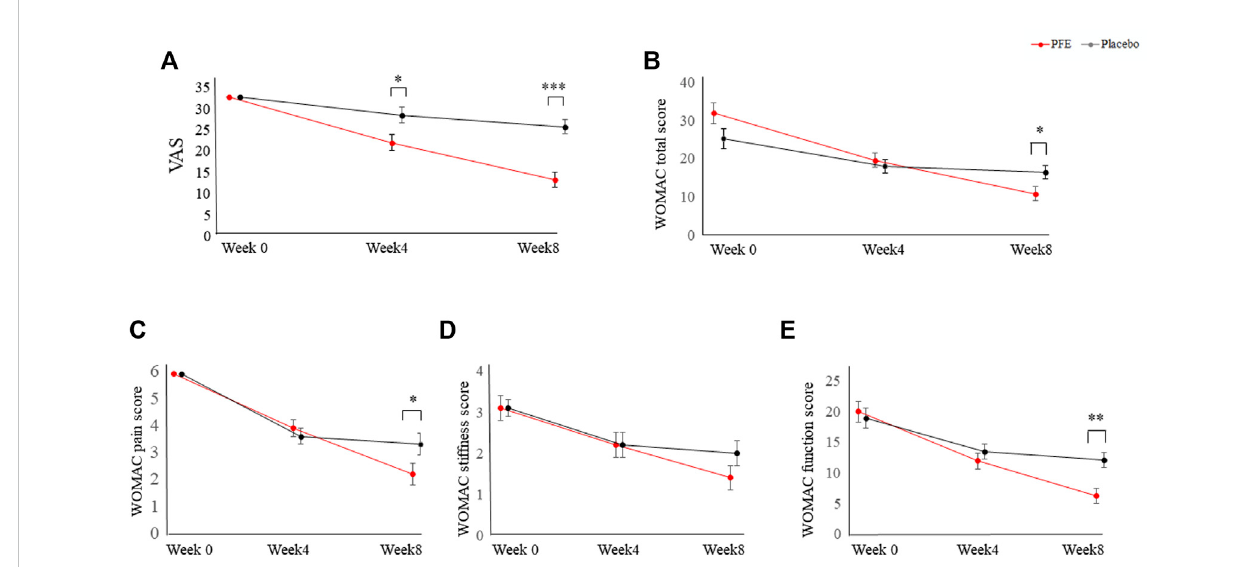
FIGURE 2 Changes in primary outcomes between the PFE group and the placebo group for eight weeks. (A) Changes in the VAS score; (B) Changes in the WOMACtotalscore; (C) ChangesintheWOMACpainscore; (D) ChangesintheWOMACstiffnessscore; (E) ChangesintheWOMACfunctionscore.Data are corrected using age and value at baseline as covariance. p -values are analyzed by repeated measures analysis of variance (ANOVA). PFE: Perilla frutescens (L.) Britton var. frutescens Extract; VAS, visual analogue scale; WOMAC, Western Ontario and McMaster Universities Osteoarthritis * p < 0.05, **: p < 0.01, ***: p < 0.001 indicates statistical signi fi cance between the change values in the PFE group and the placebo group. p -values are calculated by repeated measures analysis of